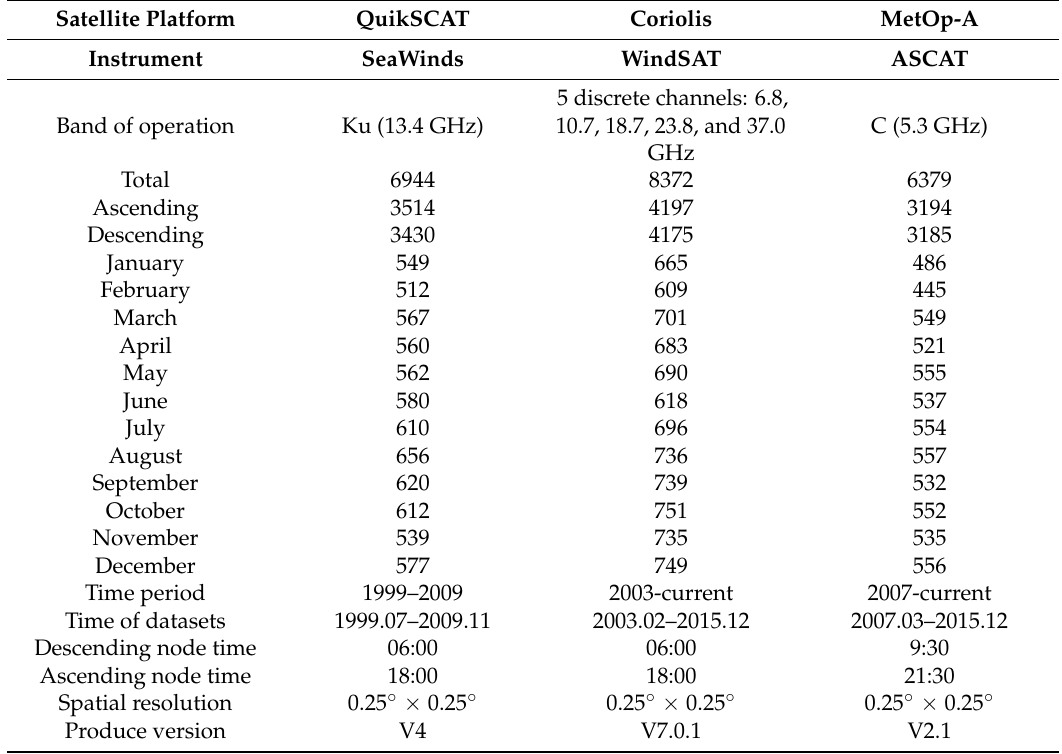
Table 1. Total numbers of QuikSCAT, WindSAT and ASCAT wind data in descending/ascending (des./asc.) mode and per month in local solar